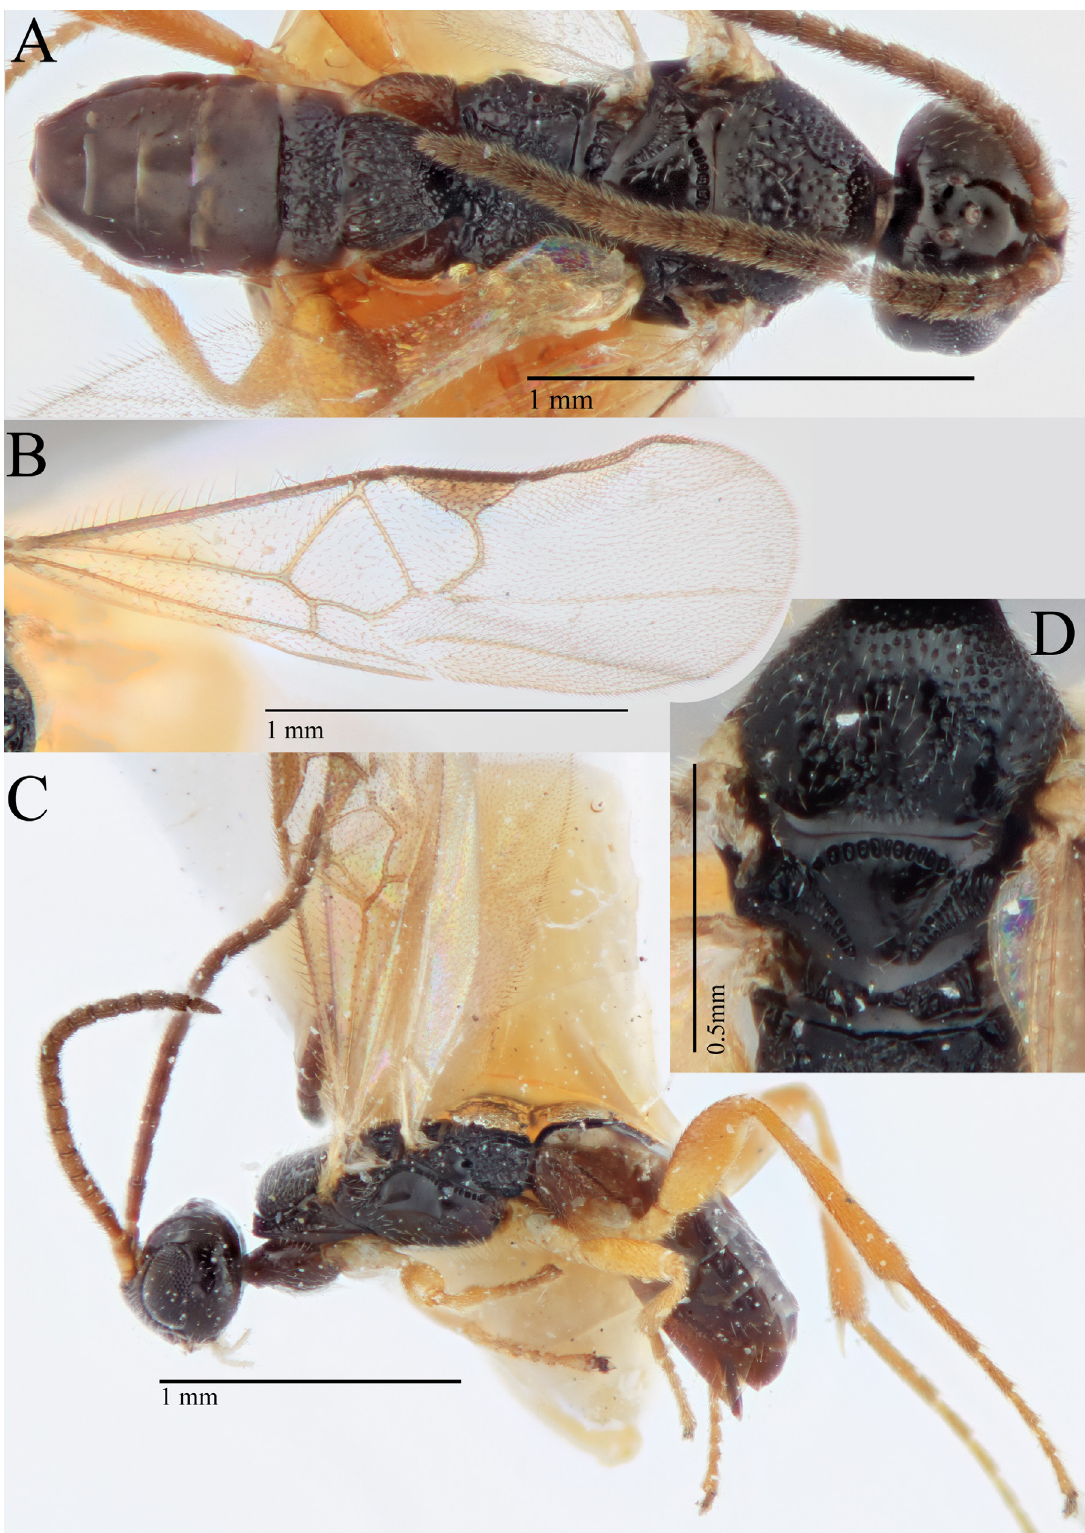
Fig. 21. Cotesia nonagriae (Olliff, 1893). A . ♀, habitus in dorsal view, specimen from Mackay (WINC). B . ♀, fore wing, specimen from Mackay (WINC). C . ♀, habitus in lateral view, specimen from Mackay (WINC). D . ♂, mesosoma in dorsal view, specimen from Bundaberg